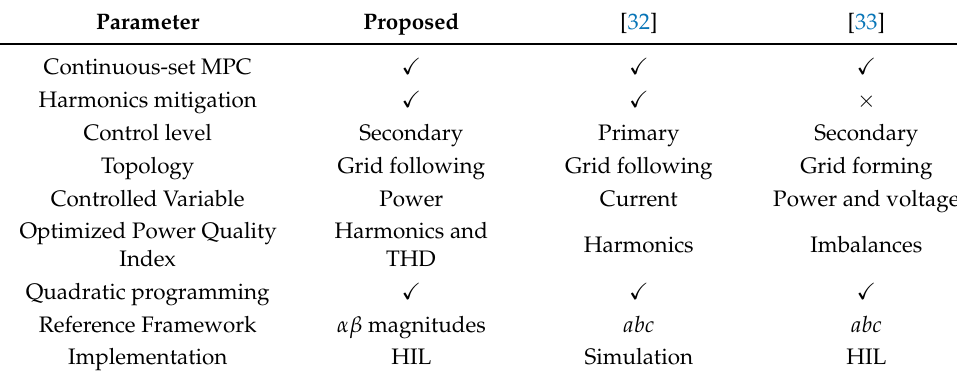
Table 2. Comparison against State-of-the-Art Techniques.